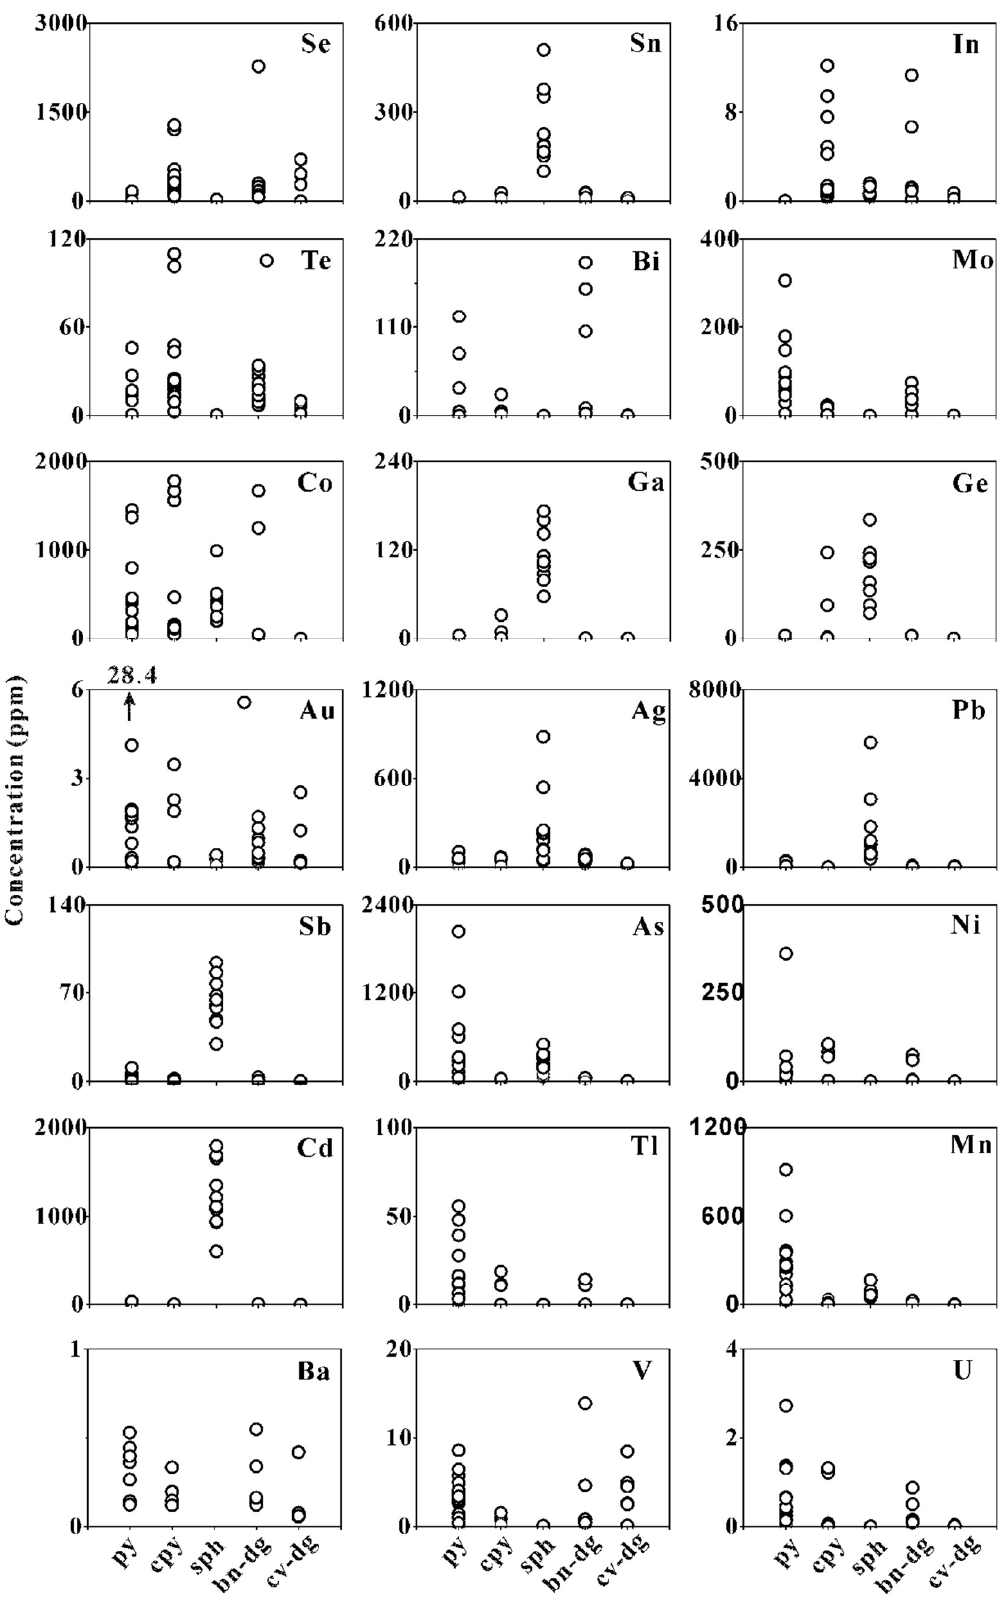
Figure 4. Distribution of trace elements in sulfide minerals from the Kairei vent field. Abbreviations: bn–dg = bornite–digenite intergrowths, cpy = chalcopyrite, cv–dg = covellite–digenite intergrowths, py = pyrite, sph = sphalerite.